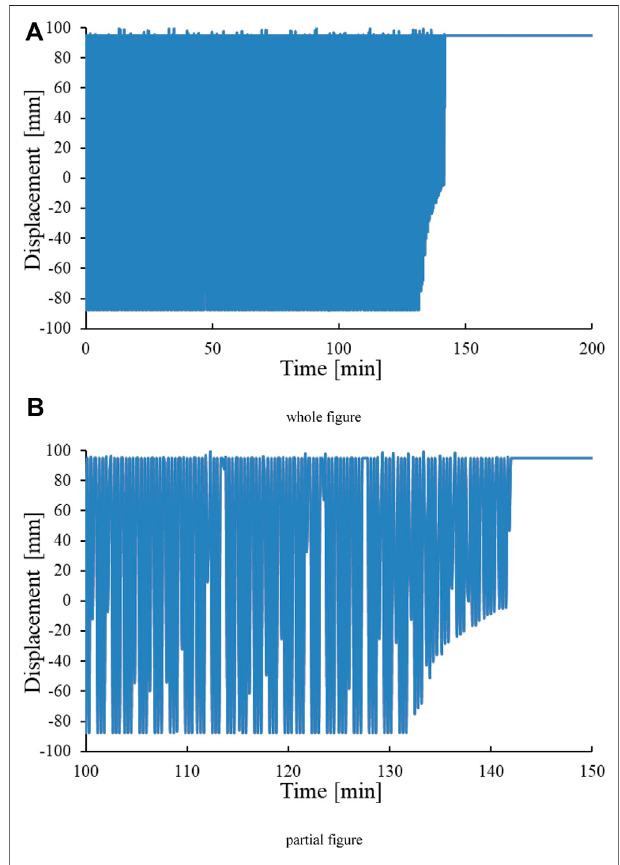
FIGURE3| Sliderpositionovertimeinthepurewatersystem. (A) Whole fi gure. (B) Partial fi gure.